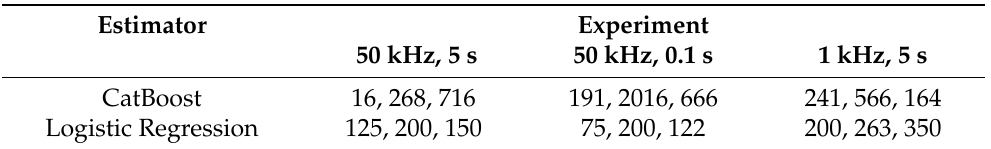
Table 6. In the current table, we report the final numbers of features after the feature selection process for the 3 cross-validation folds, CatBoost and logistic regression estimators and all the experiments. The experiments are encoded as “sampling frequency, time window length”.